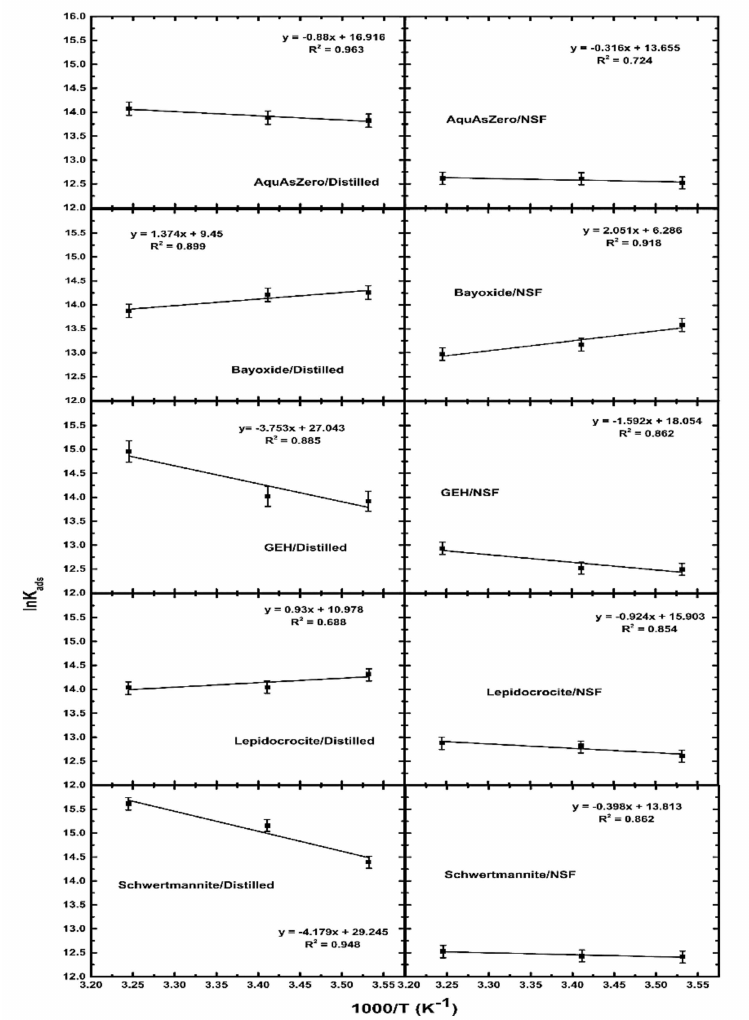
Figure 2. Van’t Hoff plots of phosphate adsorption data in the examined experimental